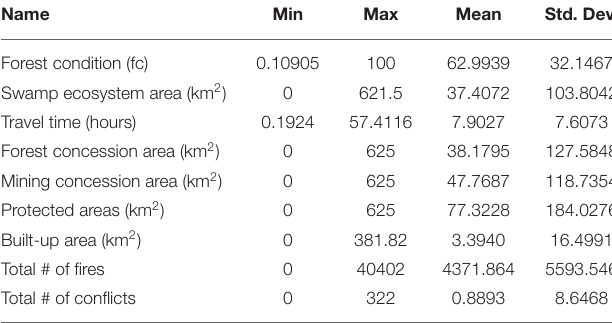
TABLE 2 | Summary of